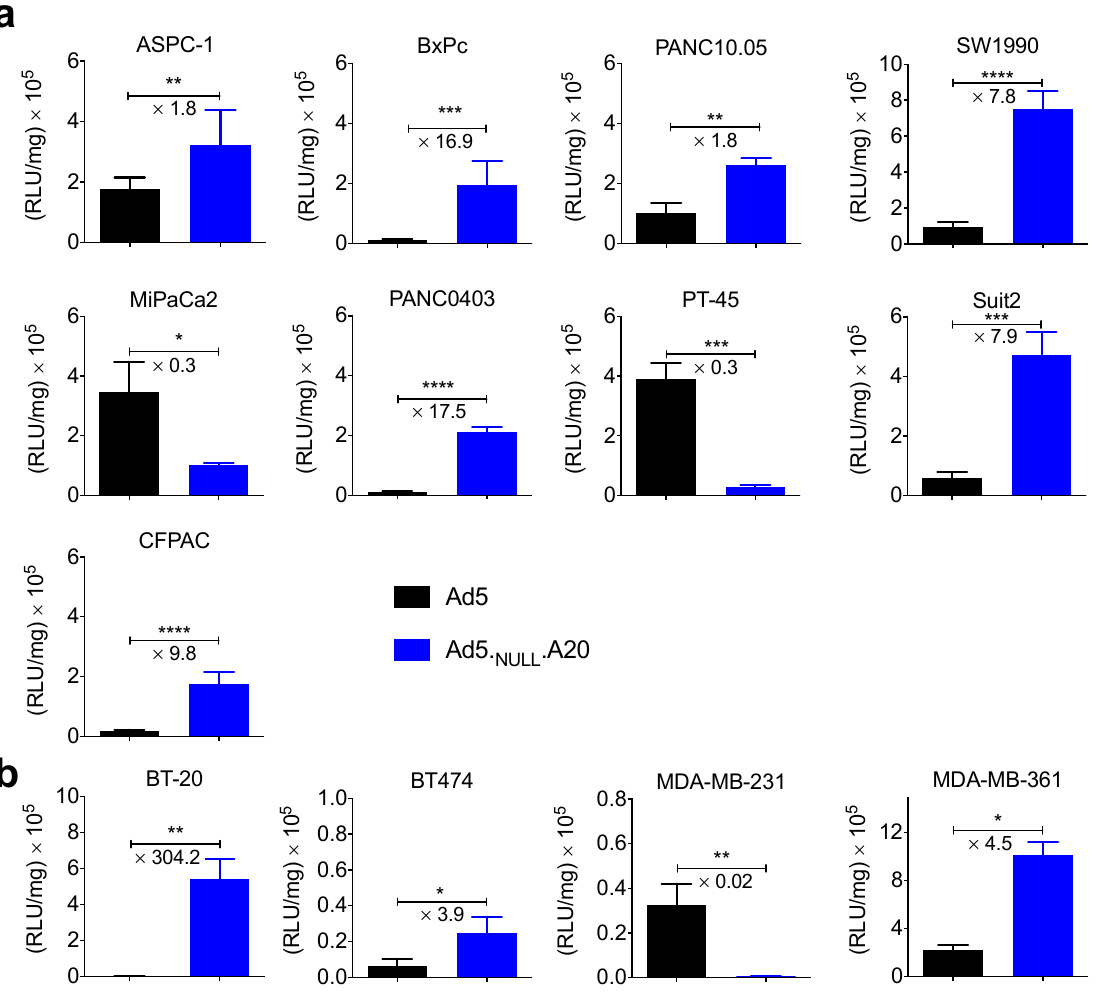
Figure 2. Transduction of pancreatic and breast cancer cell lines with Ad5 and Ad5 NULL -A20. Nine pancreatic cell lines ( a ) and four breast cancer cell lines ( b ) were transduced with 5000 vp/cell of either Ad5 (black bars) or Ad5 NULL -A20 (blue bars) vectors expressing luciferase. Luciferase expression was quantified 48 h postinfection and normalized to total cellular protein. Error bars represent standard deviation of n = 4. (* p < 0.05; ** p < 0.01; *** p < 0.001; **** p < 0.0001).